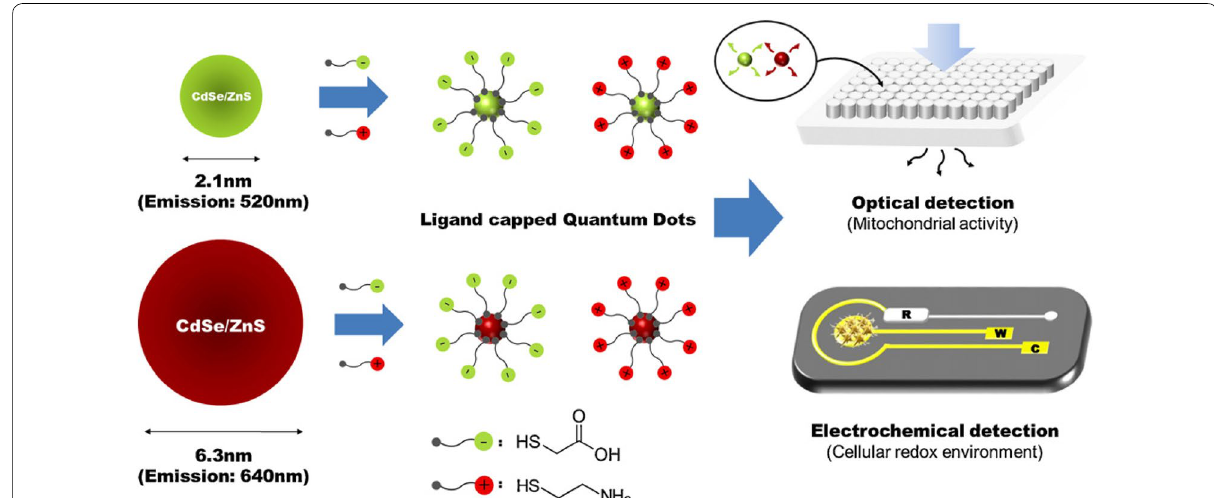
Fig. 4 Schematics for the detection of cytotoxicity of thioglycolic acid (TA) or cysteamine (CA)‑capped green and red quantum dots (QDs) based on cell chip and conventional MTT assay. ‘R’, ‘W’, and ‘C’ mean the reference, working, and counter electrodes, respectively (Reprinted with permis‑ sion from [40]. Copyright @ 2012